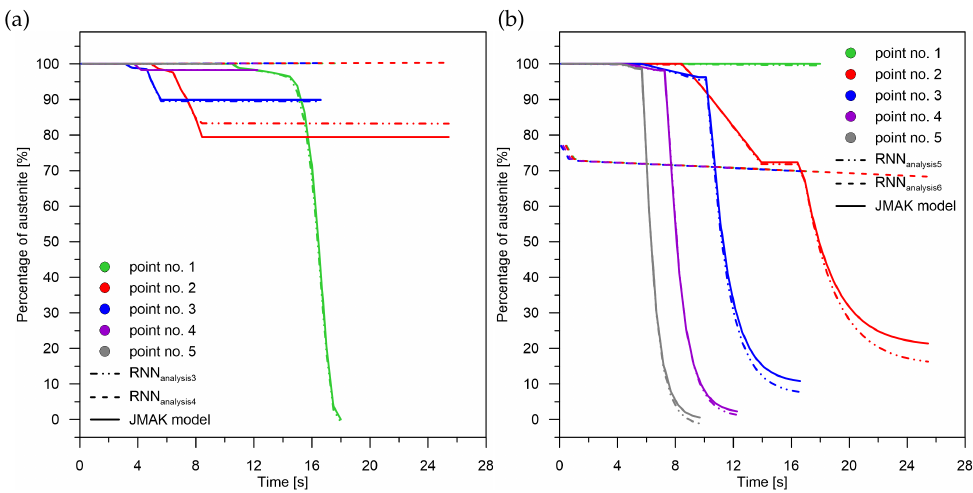
Figure 11. Analysis of phase transformation kinetics. ( a ) Analysis No. 3 and No. 4. ( b ) Analysis No. 5 and No. 6.